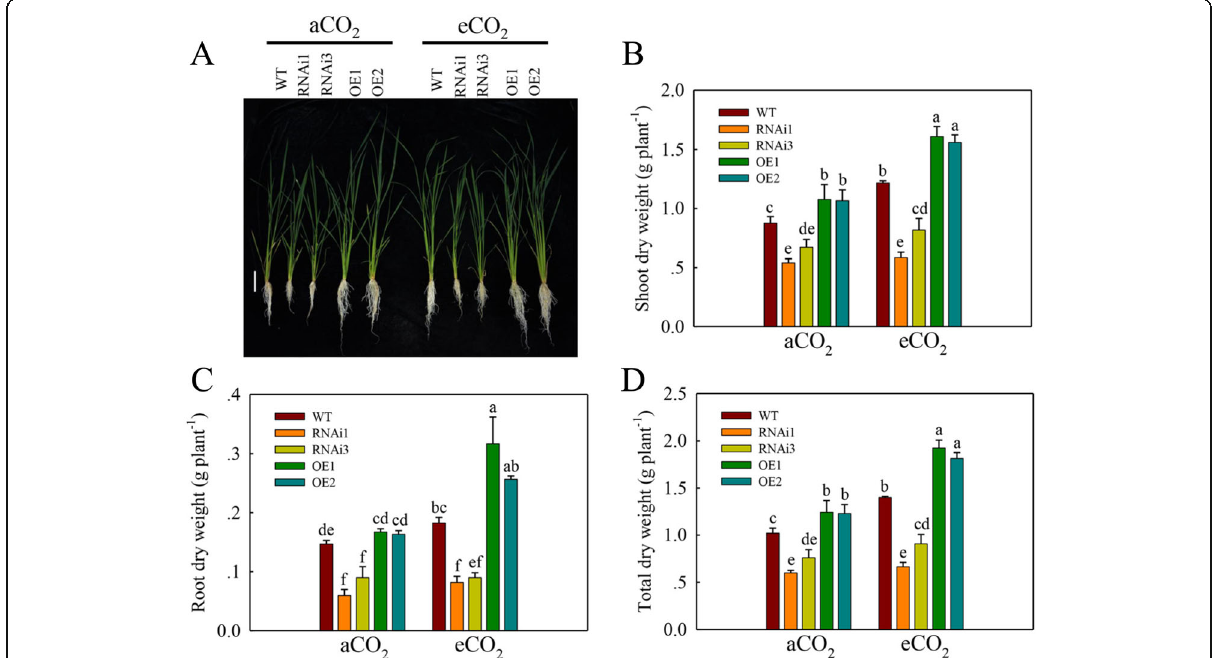
Fig. 3 Growth of wild-type rice and transgenic lines under aCO 2 and eCO 2 . Seedlings were grown under aCO 2 (400 ppm) or eCO 2 (800 ppm) in growth chambers for 4 weeks. ( A ) Growth phenotypes of WT, RNAi lines and OE lines of qPE9-1 under aCO 2 or eCO 2 for 4 weeks. Bar: 10 cm. ( B , C and D ) Shoot dry weight, root dry weight and total dry weight of WT, RNAi lines and OE lines of qPE9-1 grown under aCO 2 or eCO 2 for 4 weeks. Values are means ± SD ( n = 5); different letters indicate significant differences ( P <